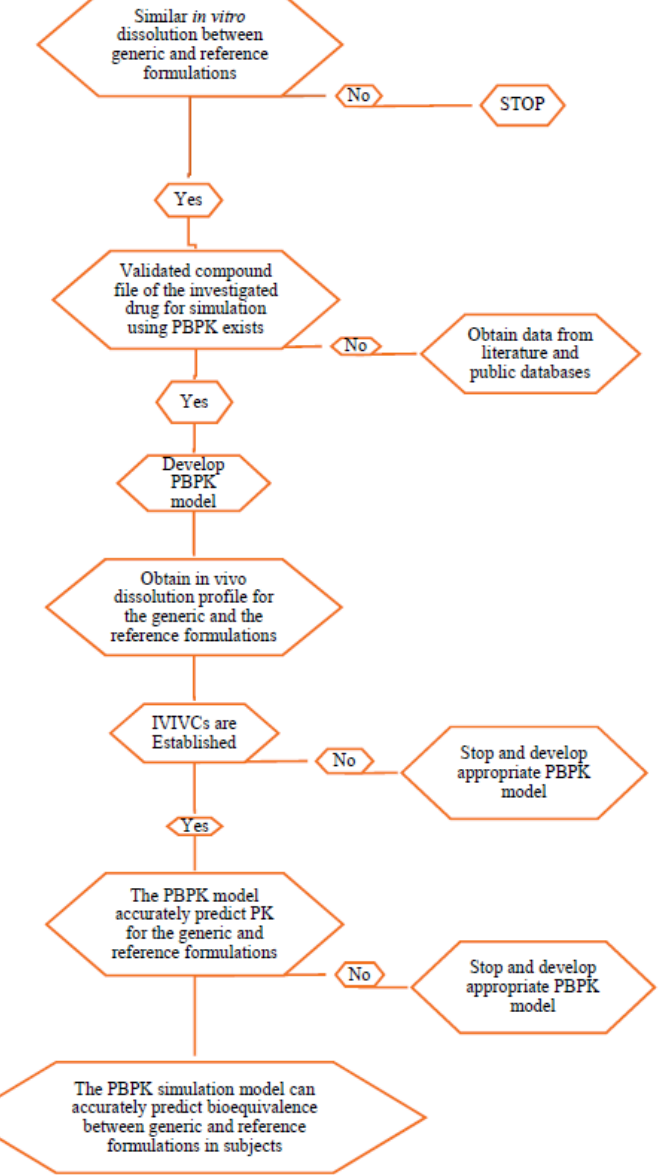
Figure 4. Typical workflow for virtual bioequivalence studies using the PBPK models.